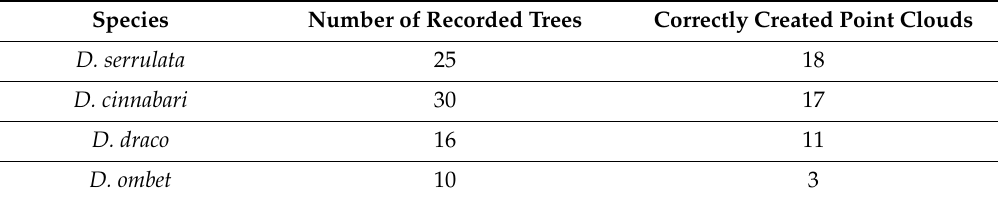
Table 1. Dracaena trees’ 3D tree point clouds correctly created. Species Number of Recorded Trees Correctly Created Point